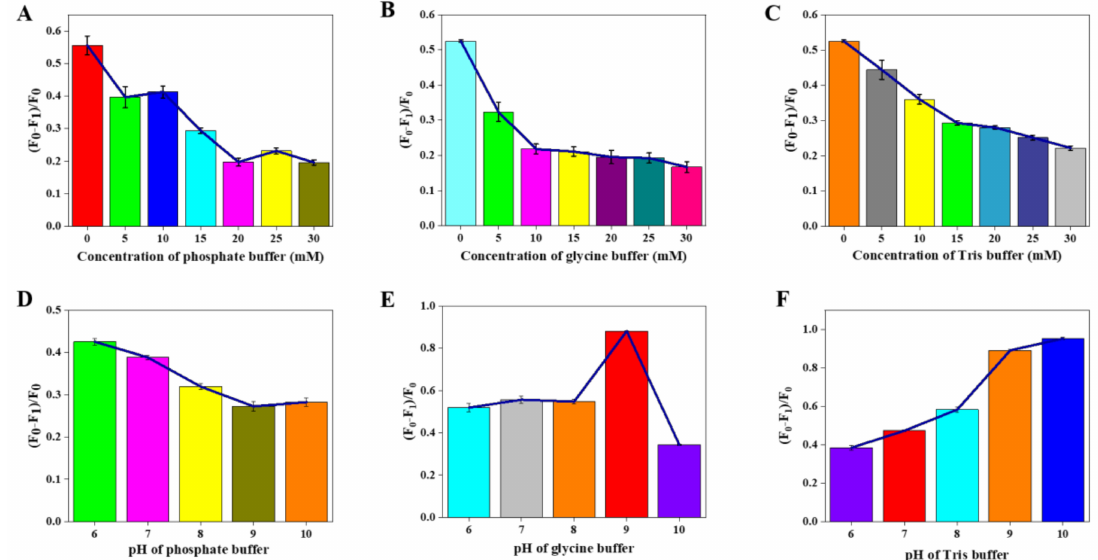
Figure 5. Effect of the concentration of ( A ) phosphate buffer, ( B ) glycine buffer, and ( C ) Tris-HCl buffer on quenching effi- ciency. Effect of the pH value of ( D ) phosphate buffer, ( E ) glycine buffer, and ( F ) Tris-HCl buffer on the quenching efficiency.